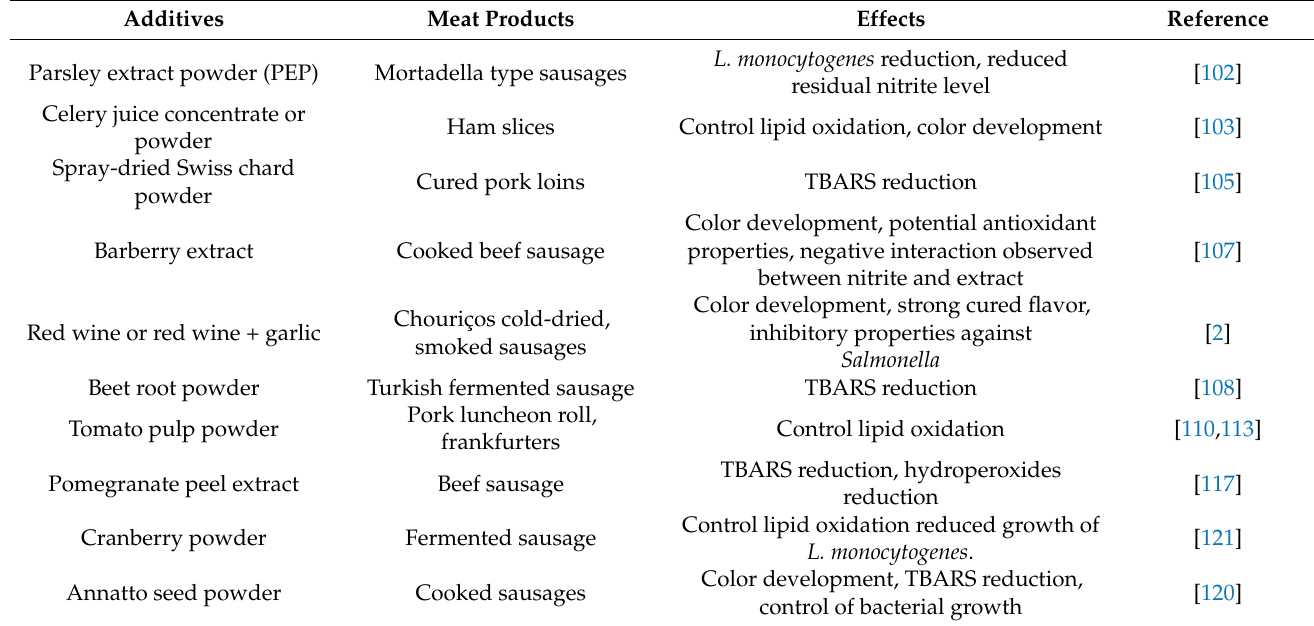
Table 1. Effect of different plant-based alternatives of nitrites on meat